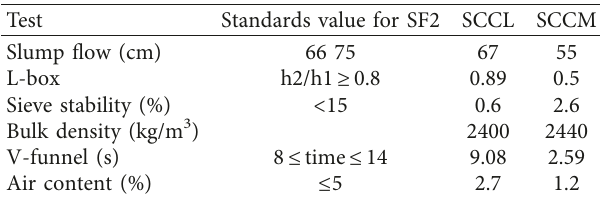
Figure 6: Apparatus for determination of water penetration depth. Table 7: Properties of two SCCs in fresh state.